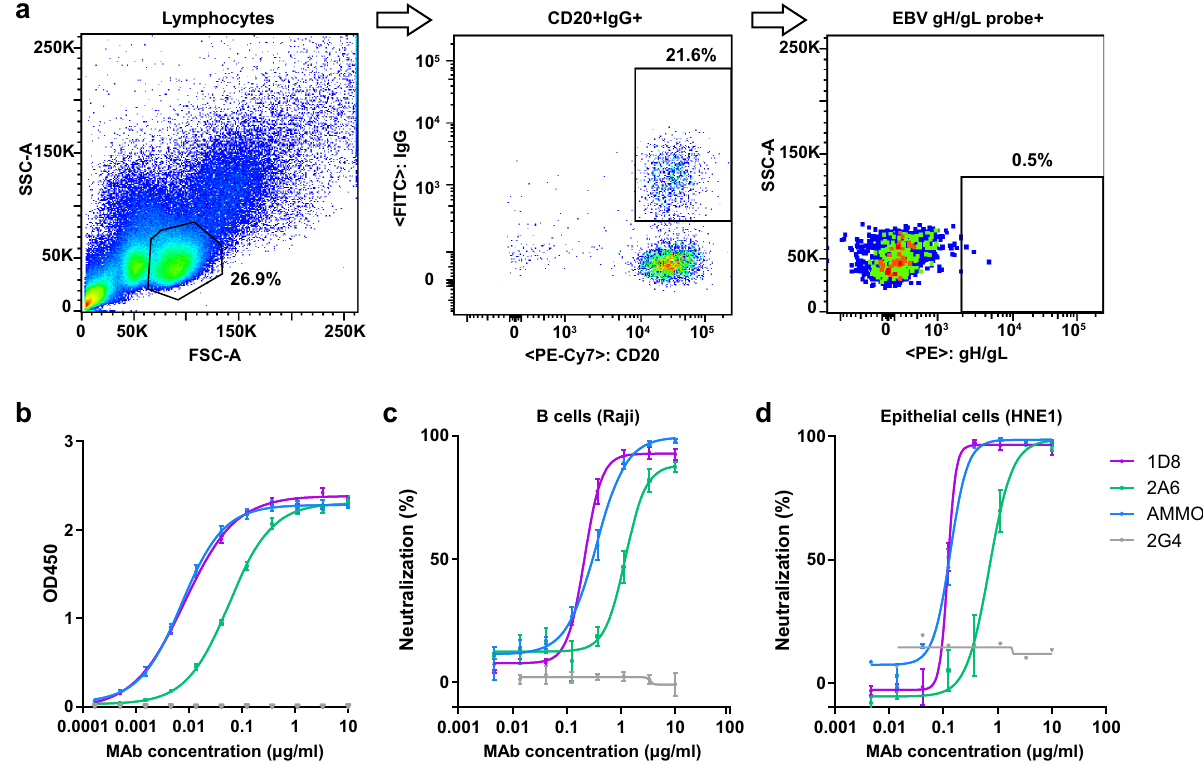
Fig. 1 Isolation of gH/gL-speci fi c monoclonal antibodies using single B cell sorting and cloning. a FACS-based sorting strategy for gH/gL-speci fi c B cells. b Binding activities of 1D8 and 2A6, the positive control AMMO1, and the negative control 2G4 to EBV gH/gL measured by ELISA. The data are presented as means ± SEM from two replicates. c Neutralizing activities of 1D8 and 2A6, the positive control AMMO1, and the negative control 2G4 against EBV infection of Raji B cell lines and ( d ) HNE1 epithelial cell line. The data shown are means ± SEM from two replicates. SSC-A, side-scatter area; FSC-A, forward-scatter area. Source data are provided as a Source Data